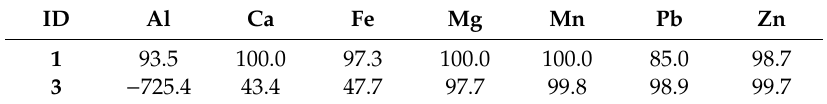
Table 6. Percentage reduction of PTEs from 50 / 50 stabilised moulds compared to raw BF Sludge. ID Al Ca Fe Mg Mn Pb Zn 1 32.8 100.0 − 100 + 100.0 − 85.2 88.9 100.0 2 92.9 100.0 − 100 + 100.0 96.1 99.7 100.0 3 − 266.7 100.0 − 100 + 99.9 100 + 100.0 100.0 − 100 + 100.0 99.6 98.6 100.0 Table 7. Percentage reduction of PTEs from 70 / 30 stabilised moulds compared to raw BF Sludge. ID Al Ca Fe Mg Mn Pb Zn 1 93.5 100.0 97.3 100.0 100.0